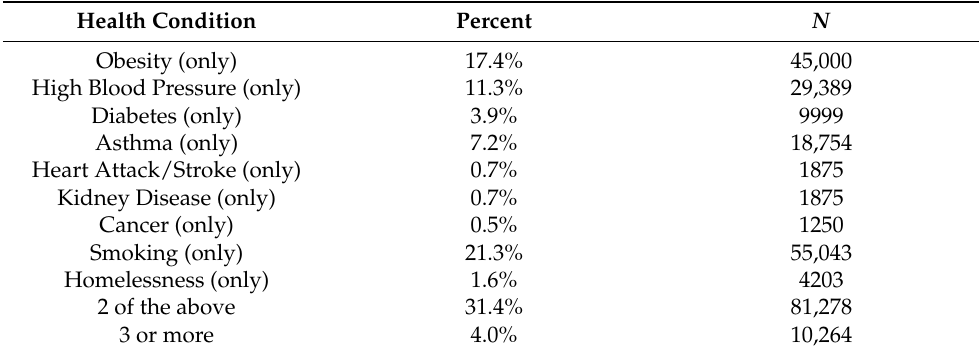
Table 8. High-Risk Pre-Existing Health Conditions Associated with Severe Illness Related to COVID-19 Among Hispanics. Health Condition N